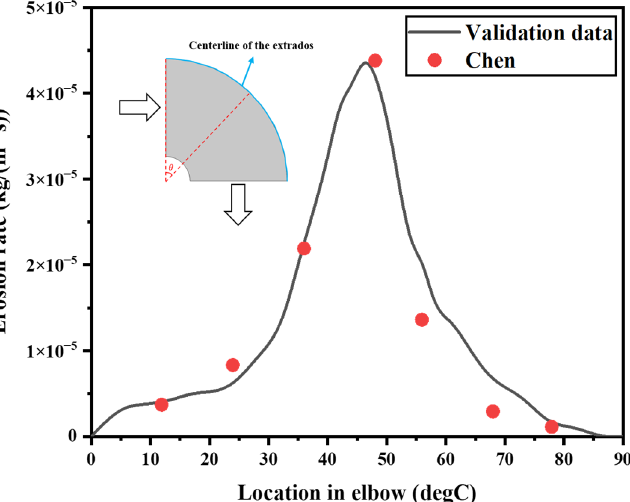
Figure 5. Comparison of simulated elbow erosion distribution with Chen’s experimental results.